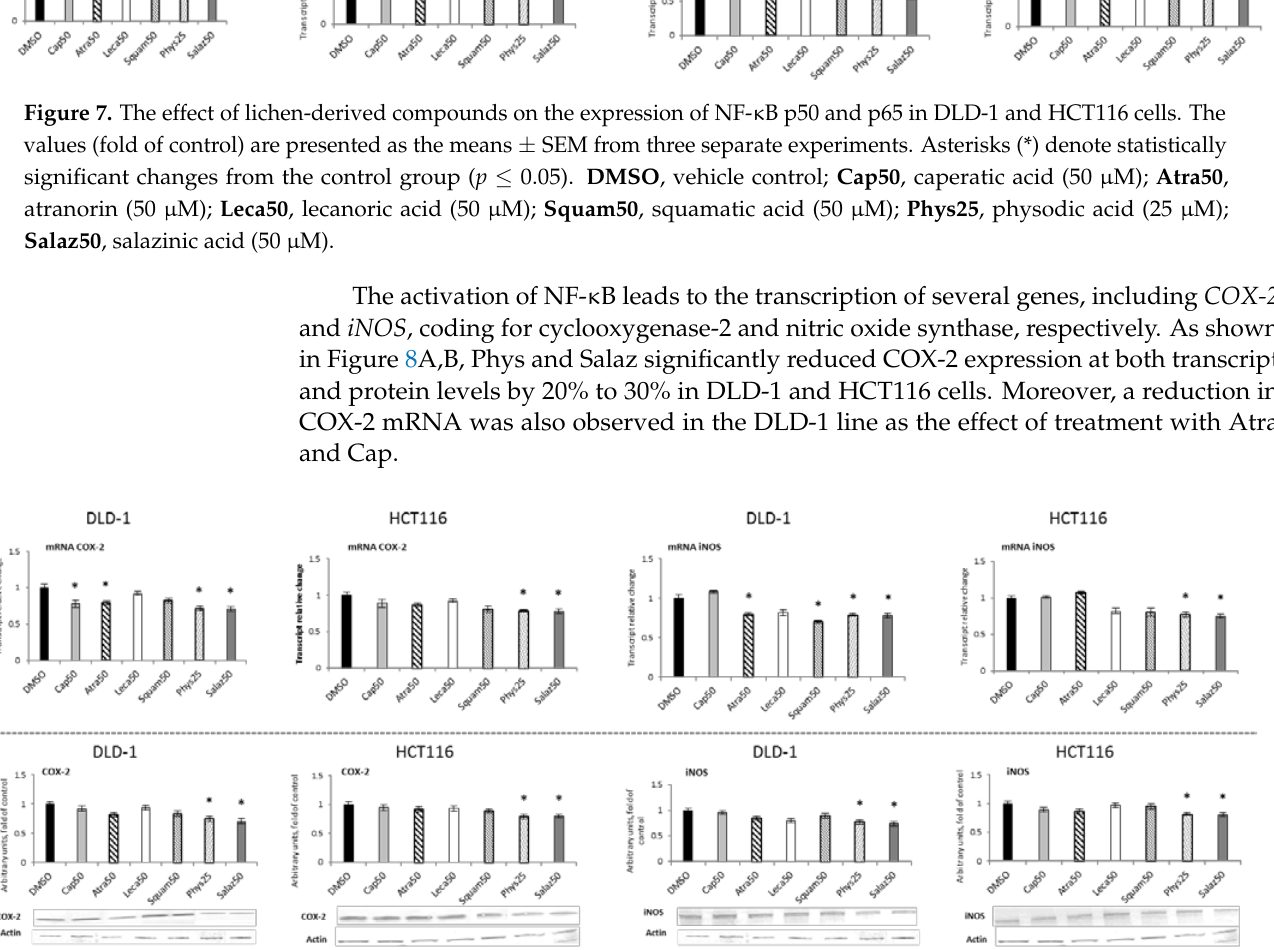
Figure 8. The effect of lichen-derived compounds on the expression of selected NF- κ B target genes: COX-2 and iNOS in DLD-1 and HCT116 cells. ( A ) Levels of COX-2 and iNOS transcripts. The values (fold of control) are presented as the means ± SEM from three separate experiments. ( B ) Levels of COX-2 and iNOS proteins. Representative Western immunoblots are presented under the graphs. Results (means ± SEM from three separate experiments) are presented as a fold change to control after normalization against the level of actin. Asterisks (*) denote statistically significant changes from the control group ( p ≤ 0.05). DMSO , vehicle control; Cap50 , caperatic acid (50 µ M); Atra50 , atranorin (50 µ M); Leca50 , lecanoric acid (50 µ M); Squam50 , squamatic acid (50 µ M); Phys25 , physodic acid (25 µ M); Salaz50 , salazinic acid (50 µ